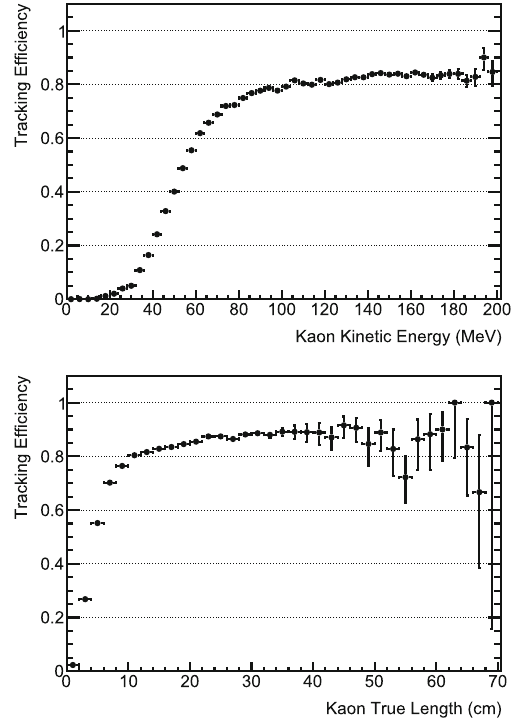
Fig. 29 Tracking efficiency for kaons in simulated proton decay events, p → K + ν , as a function of kaon kinetic energy (top) and true path length (bottom)